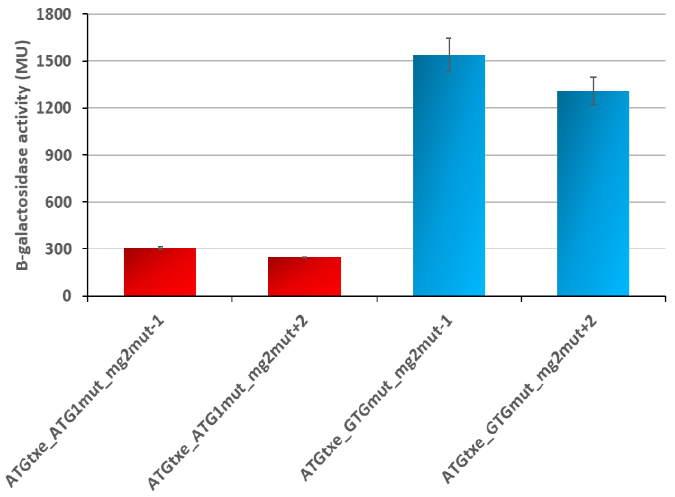
Figure 7. Upon mg2 inactivation and creation of a new stop codon in the same reading frame, ATG1 takes on a function of a start codon of the new minigene. β -galactosidase activities were assessed in the E. coli ∆5∆lac strain carrying pRW225 derivatives, as indicated on the graph. Reporter activity was measured when cell cultures reached OD600 ≈ 0.5. These results are the average of at least three independent experiments; error bars represent standard deviation (S.D.). Calculated p -values showed statistically significant differences between ATG1mut and GTGmut derivatives in the corresponding reading frames, − 1 and +2, respectively.